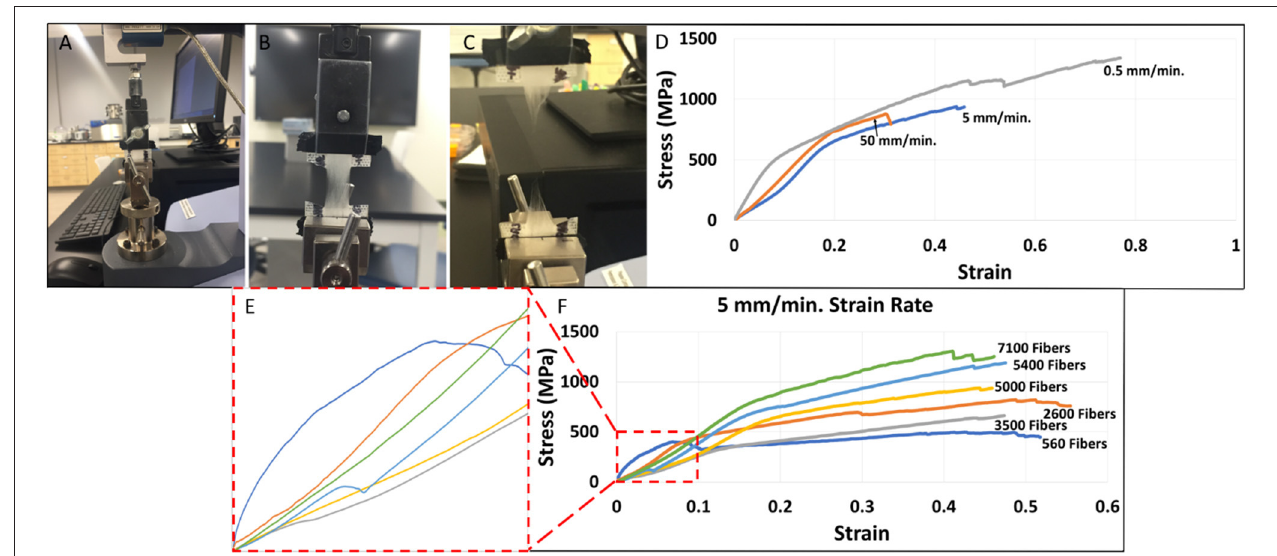
FIGURE 4 | (A) Initial tensile testing setup performed on a Shimadzu EZ-SX mechanical tester. (B) Elongation of electrospun PCL nanofibers during testing. (C) Failure of electrospun PCL nanofibers at the conclusion of tensile testing. (D) Representative stress-strain curves by strain rate (mm/min.) for individual fiber mat samples containing 4,753–4,976 fibers. (E) Enlarged linear regions of the stress-strain curves by fiber number where Young’s modulus values were selected. (F) Stress-strain curves by fiber number at a 5 mm/min. strain rate (individual representative samples).